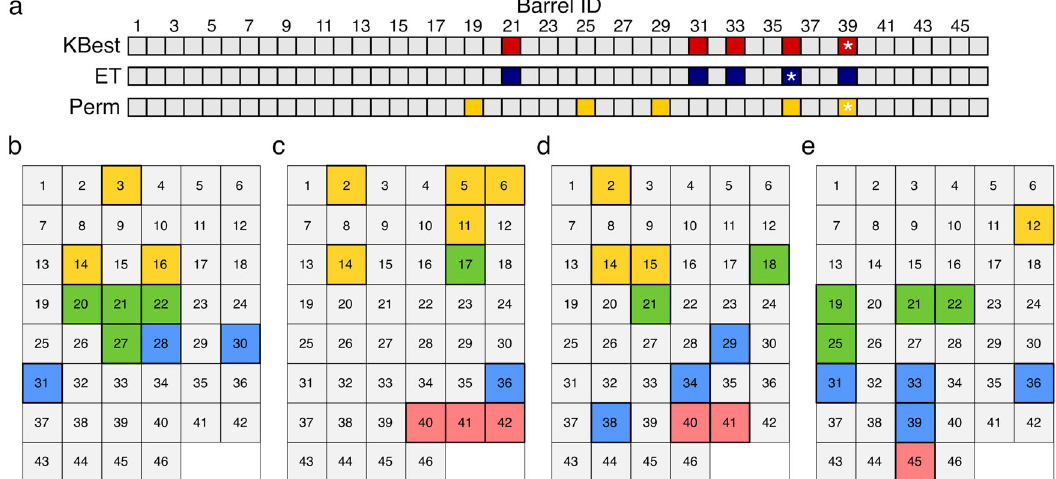
selection method is highlighted (*). The 10 α HBs that contribute most to signal in challenges with AAs ( b ), FAs ( c ), CHOs ( d ), and 2-way NASH sera classi fi cation ( e ). α HB rankings are taken from the combined rank of all three feature selection methods. Color scheme for b – e : Hydrophobic α HBs, yellow; polar mutations, green; charged mutations, blue; aromatic mutations,